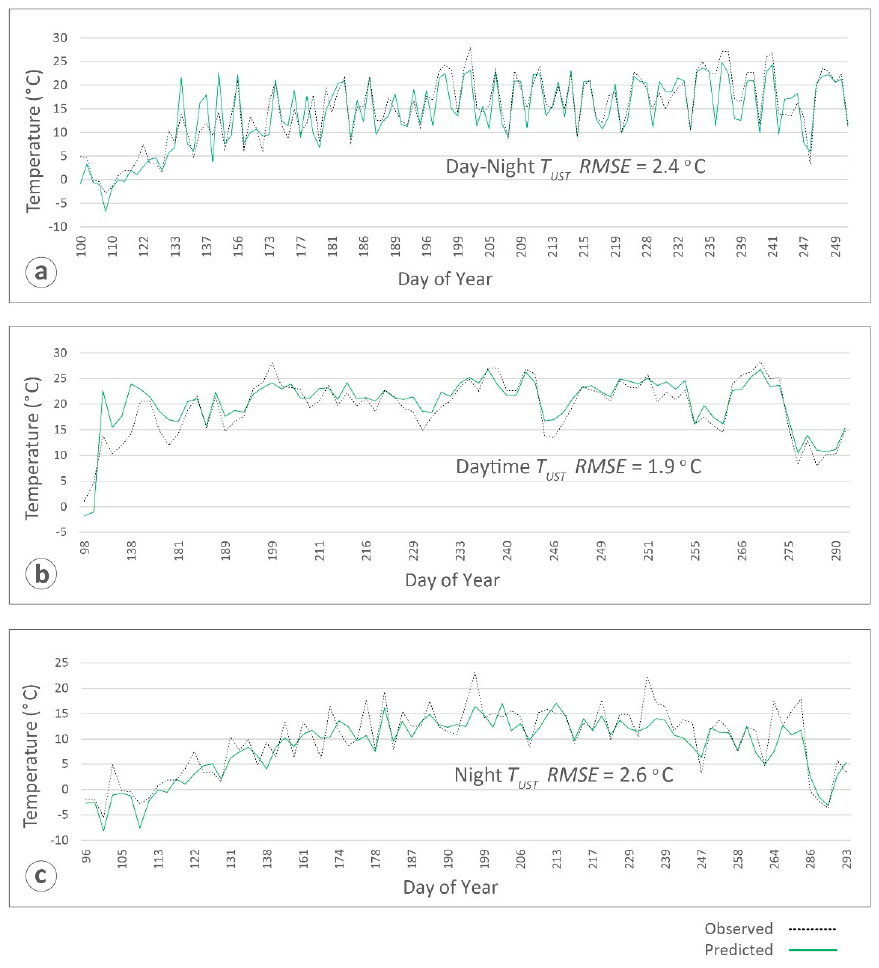
Table 6. Comprehensive results of the top-ranked T ust models. Coefficient of determination (R 2 ), mean absolute error (MAE), root mean square error (RMSE).